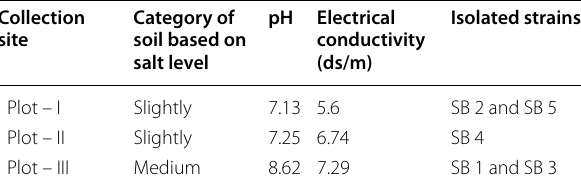
Table 1 Physio-chemical characteristics of soil samples used for isolation of stress-tolerant